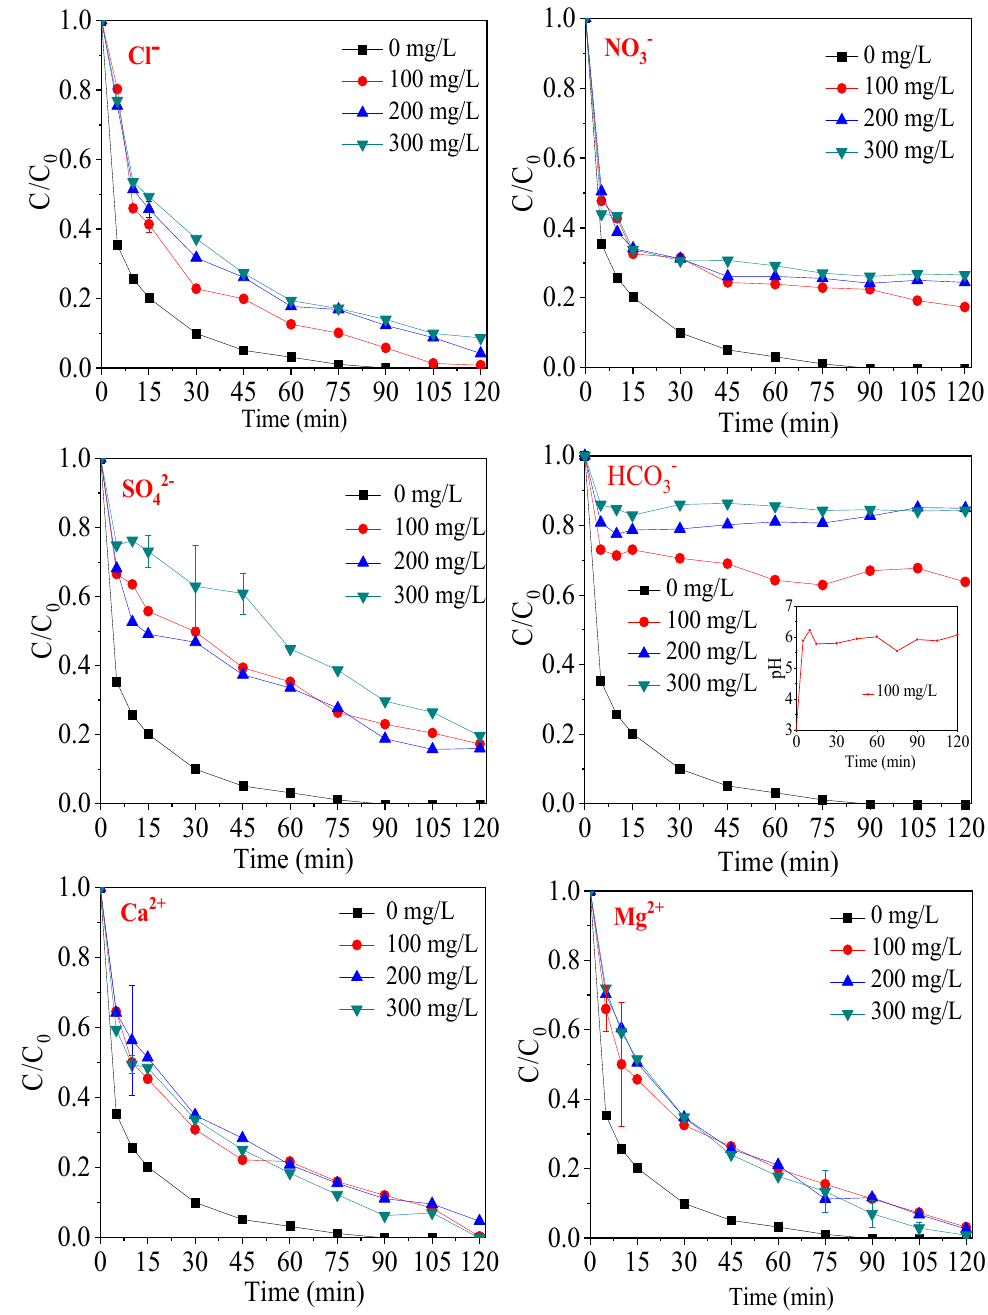
Figure 6. Effect of different anions and cations on the removal of Cr(VI) by nZVI in solution. ([Cr(VI)] = 25 mg/L, [nZVI] = 0.5 g/L, pH = 3, T = 293 K, Time = 120 min). As shown in Figure 6, SO 42 − had a strong inhibitory effect on the kinetics of Cr(VI) removal by nZVI and, the higher the SO 42 − concentration, the stronger the inhibition. When the concentration of SO 42– increased from 0 to 300 mg/L, the removal of Cr(VI)